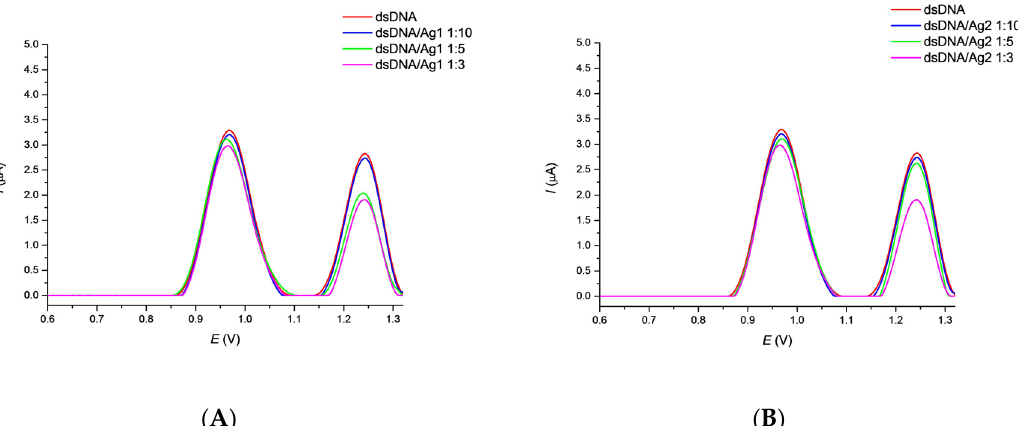
Figure 2. SWV curves recorded after 30 min. incubation of the DNA/GCE biosensor with Ag1 ( A ) and Ag2 ( B ) nanoparticles followed by 2 min. biosensor treatment in 0.1 mol·L − 1 PB pH 7.4. SWV conditions: amplitude 20 mV, frequency 50 Hz, step potential 4 mV and scan rate 200 mV·s − 1 .